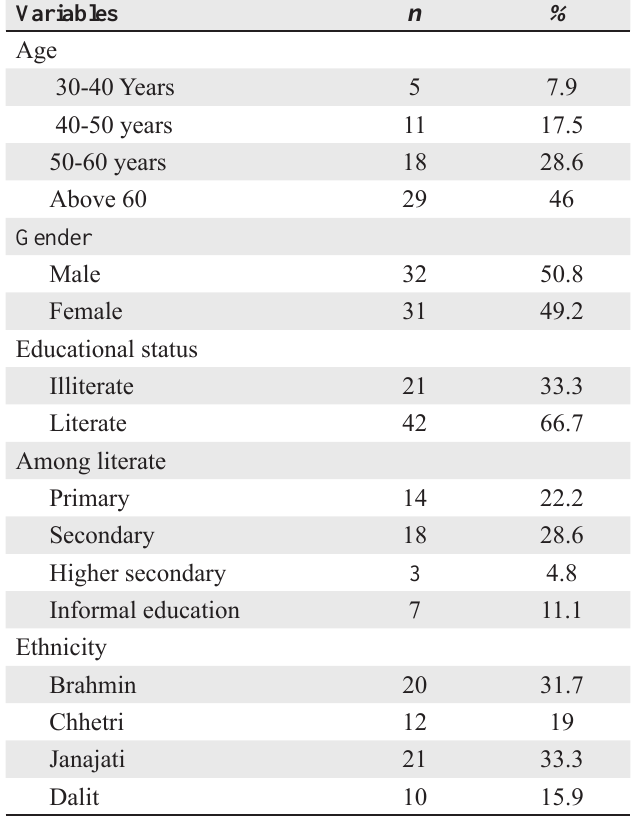
Table 1 : Socio-demographic profile of the participants